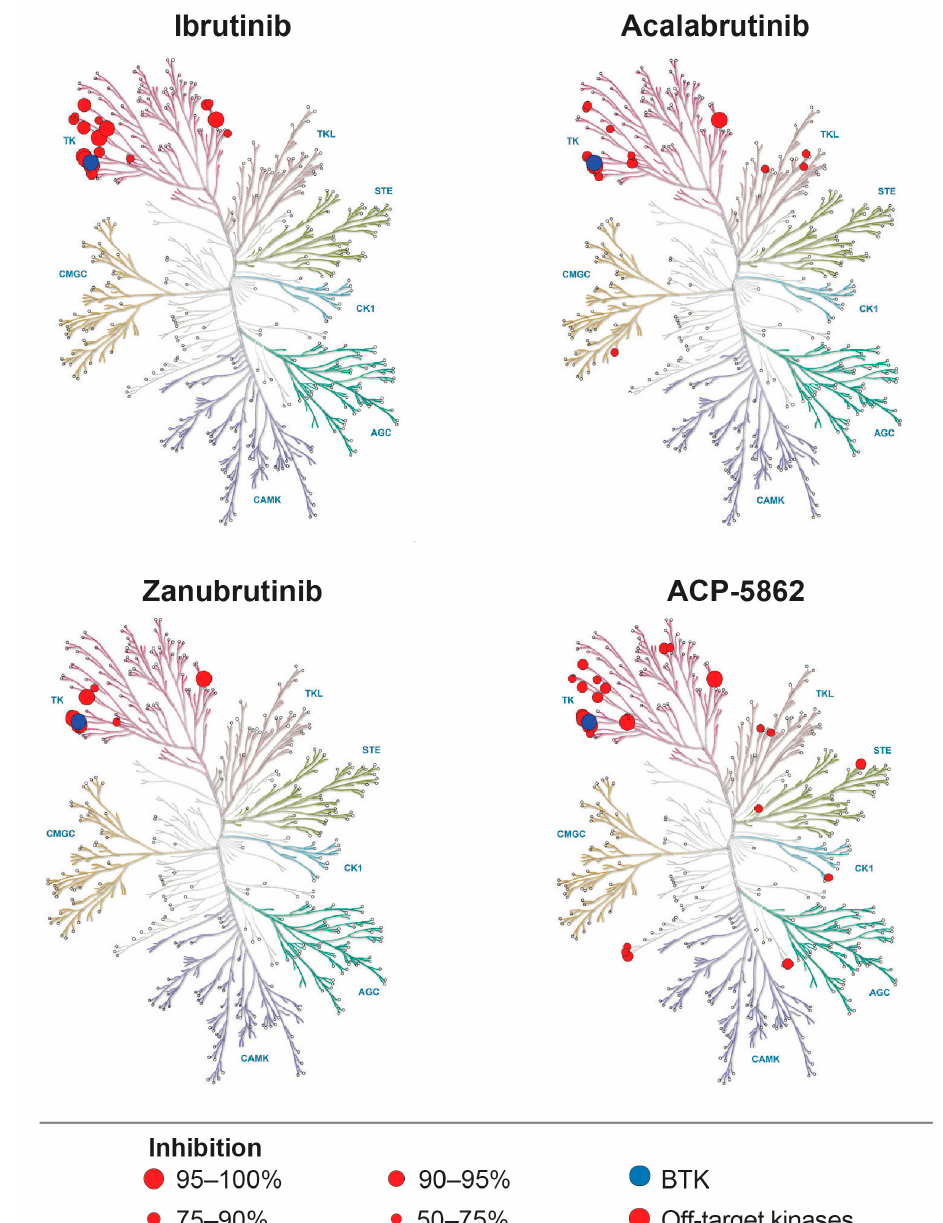
Figure 2. Kinase selectivity of ibrutinib, acalabrutinib, ACP-5862 (major metabolite of acalabrutinib), and zanubrutinib. Adapted with permission from Figure 2 in Shadman et al. (2021) [28]. Kinase selectivity assay was performed by Reaction Biology Corp. at 100x the IC50 value against BTK for ibrutinib (0.32 nM), acalabrutinib (24 nM), ACP-5862 (63 nM), and zanubrutinib (0.71 nM).